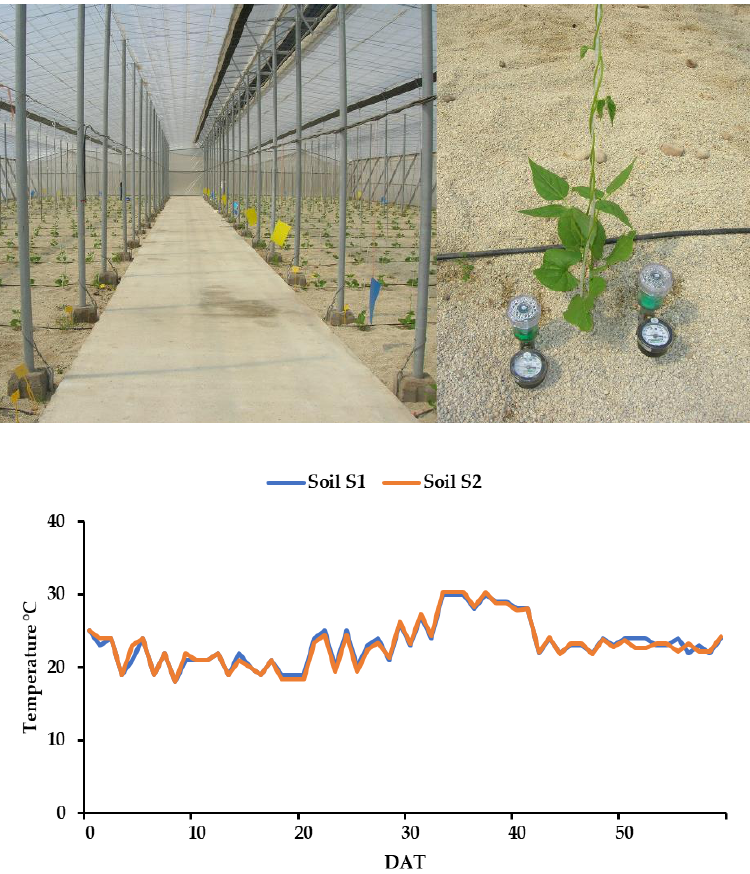
Figure 1. Plant material, greenhouse facilities, and mean temperature of two greenhouses (soil S 1 and soil S 2 ).